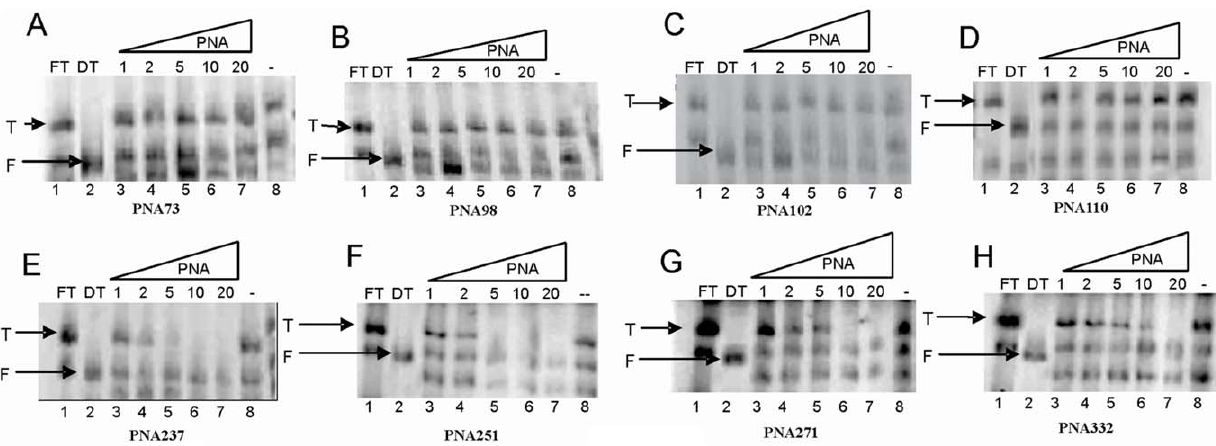
Figure 8. Effect of PNA oligomers on HIV-1 template-switching. Samples were analyzed on the 6% denaturing TBE gel. Each gel has the following loading pattern- Lane 1: HIV-1 leader transcripts including the AUG codon of gag gene, Lane 2: Donor transcript, Lane 3–7: Donor and acceptor transcripts with increasing concentration of anti-sense PNAs in molar ratio (with respect to the concentration of donor transcript) as indicated on top of each gel (Reverse transcribed with 0.2 unit of HIV-1RT/ m l), Lane 8- Donor and acceptor transcripts without PNA oligo {Reverse transcribed with 0.2 unit of HIV-1RT/ m l (from Lane 3 to 8 in each panel )},. FT- Full-length transcript, DT- Donor transcript, T- Template-switched product (Lane 3 to 8), F- Full-length donor product (Lane 3 to 8). doi:10.1371/journal.pone.0049310.g008 comparison to any DNA or RNA antisense sequences. To prove the binding of PNA oligomer to DNA the melting experiments were performed and their results suggested that all 8 PNAs (Table 1) have higher thermal stability with corresponding RNA as compared to DNA (Table 2, Fig. 3). The PNA73: RNA duplex had lowest GC content (5 GC pairing), a reason behind the lowest T m in comparison to other PNA:RNA duplexes, having higher